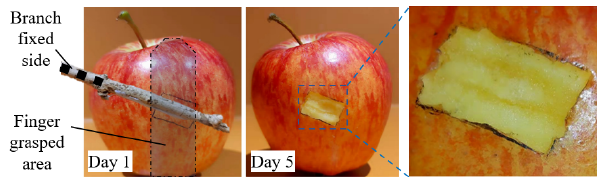
Figure 9. Bruise damage: grasp with sensing turned off.